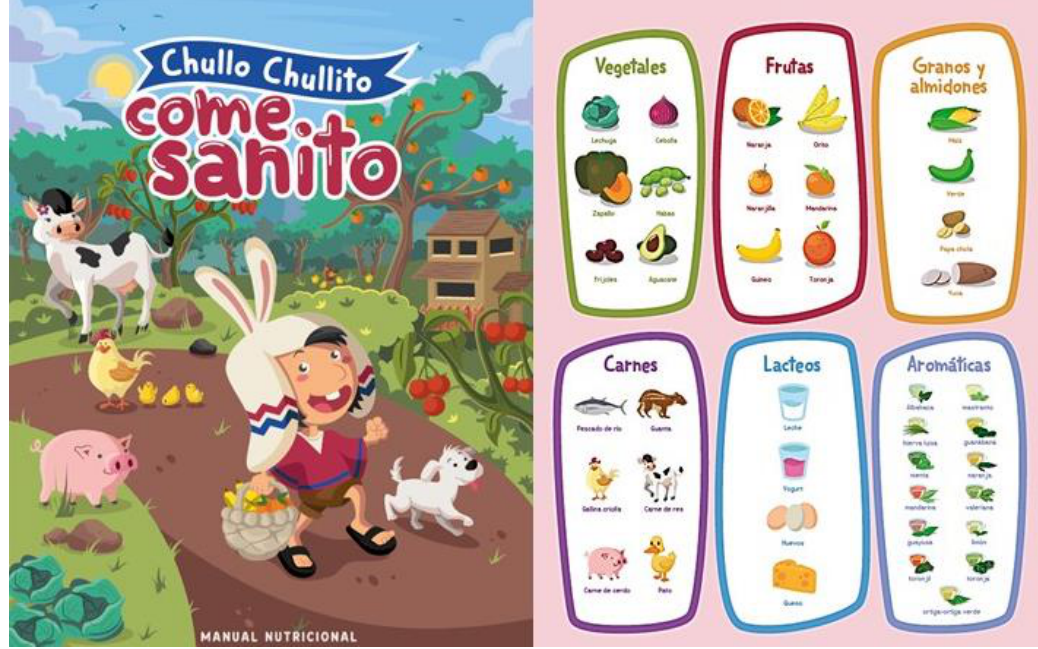
Figure 7. A nutrition education booklet from Ecuador that includes WFPs as a food group. On the left, the cover depicts the forest as an alternative source of foods, mainly fruits, while on the right, five food groups are shown along with a list of 13 WFPs (mostly aromatic plants) used for preparing hot beverages.